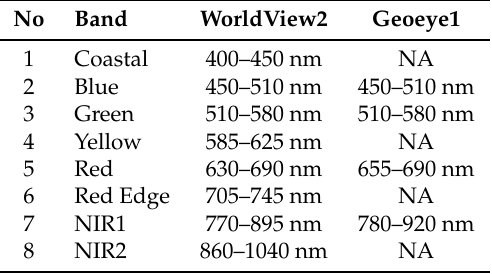
Table 1. WorldView2 and GeoEye1 bands.